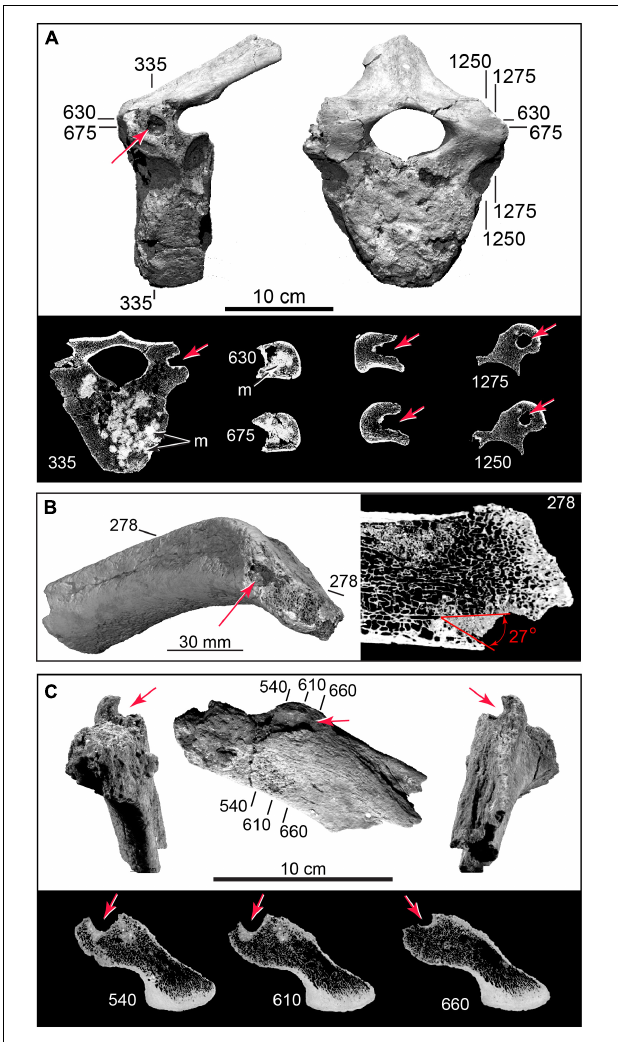
FIGURE 8 | 3D CT volumetric models and cross-sections of cylindrical punctures and cryptic punctures in vertebra and rib. (A) Thoracic vertebra with deep puncture in left transverse process; CT slices (below) showing puncture geometry in cross-section; and puncture cluster infilled by dense (bright) sediment (TMM 47004-1.22). (B) Puncture in rib head (TMM 47004-1.36). (C) Rib head (TMM 47004-1.2), with large-diameter ( ∼ 10 mm) cylindrical gouge, and CT cross sections. Numbers refer to slice planes in CT